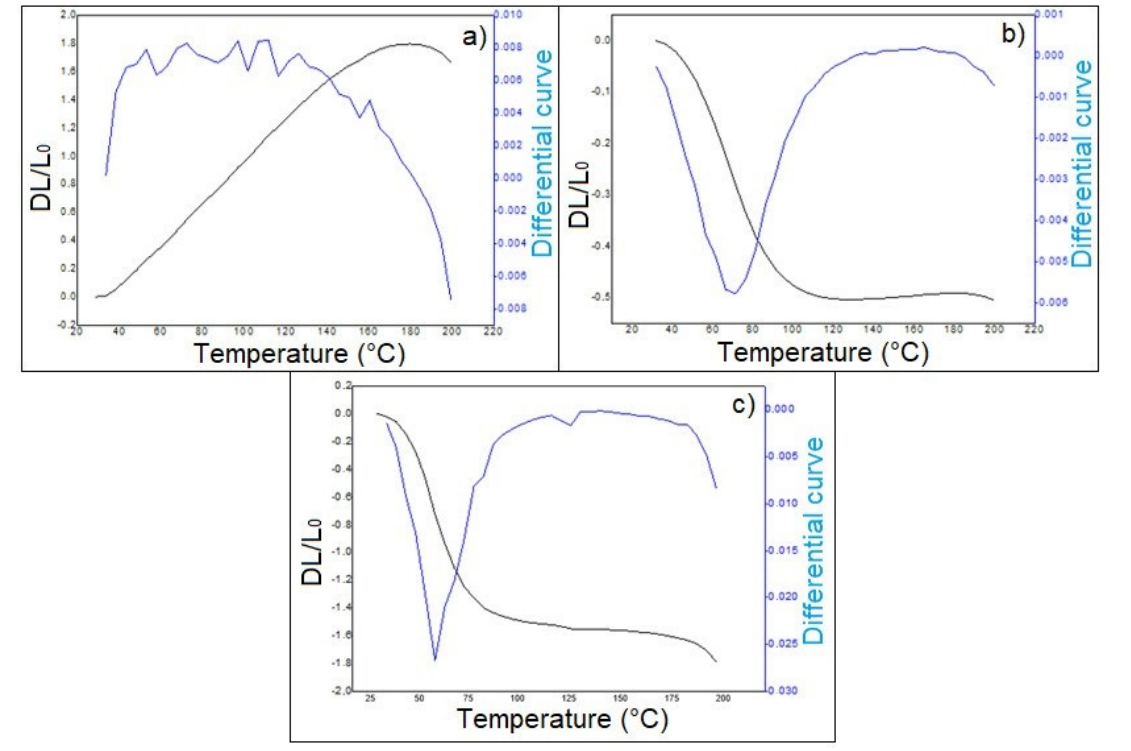
Figure 7. Dilatometry curves for the neat COPU resin ( a ), novel luffa-reinforced composite ( b ), and commercial OSB ( c ).